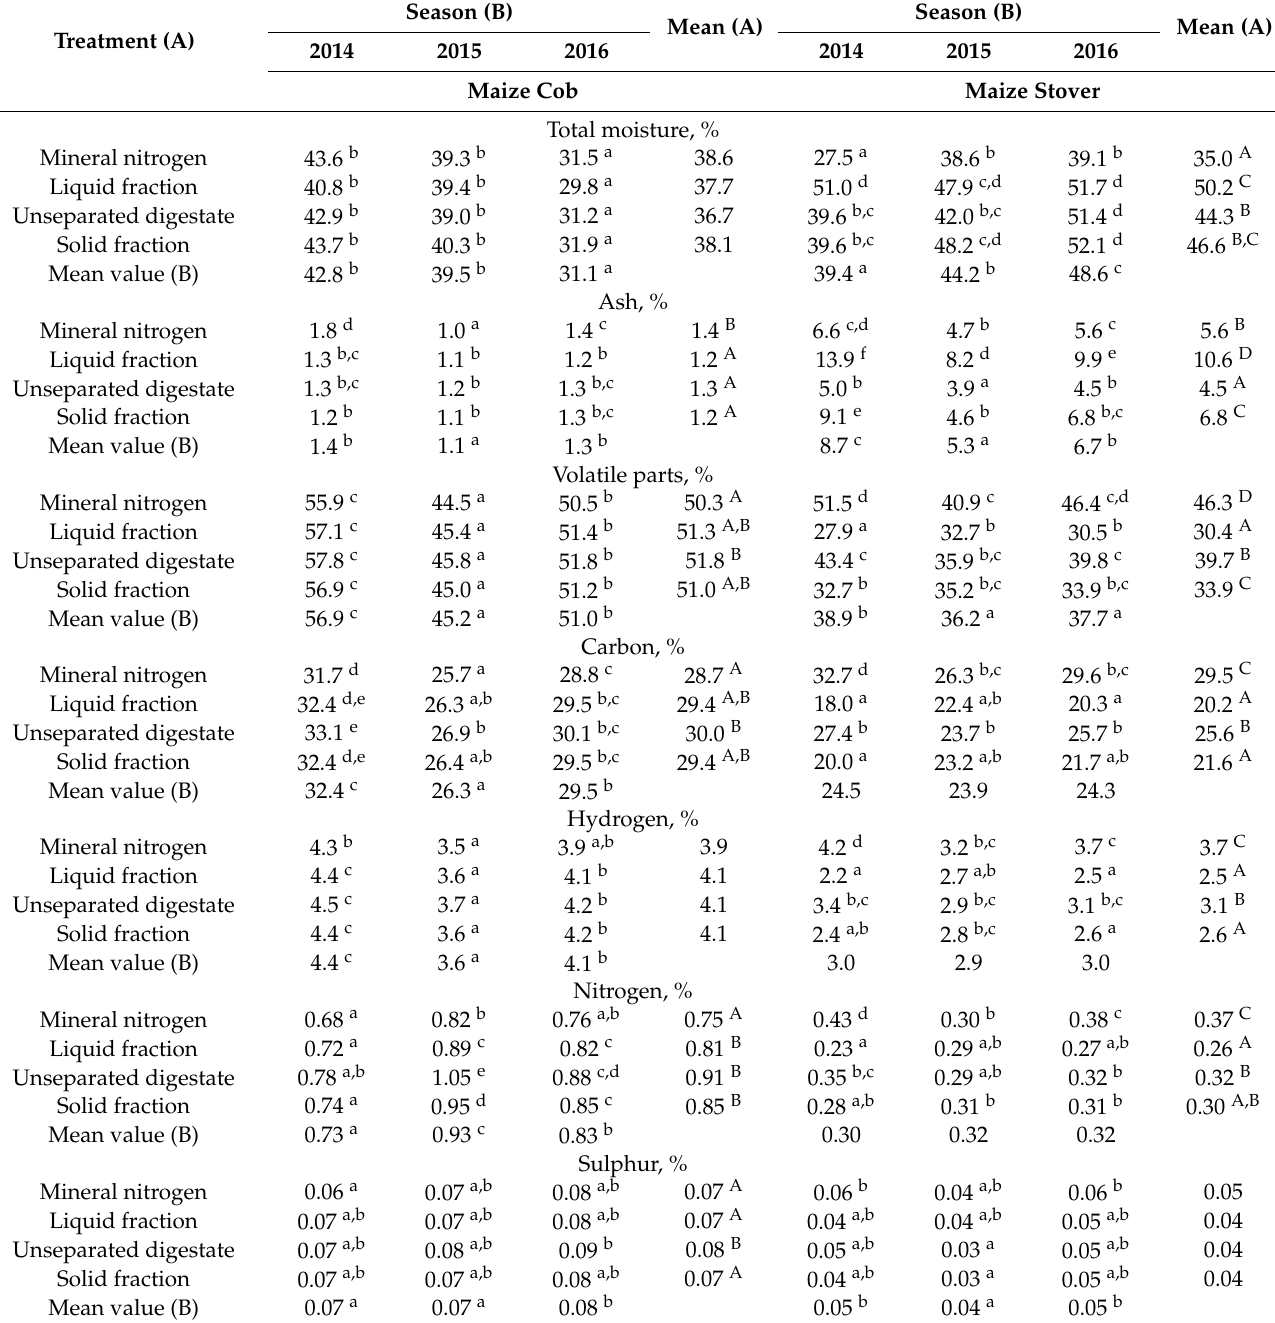
Table 3. Effects of fertilization on chemical properties of maize biomass